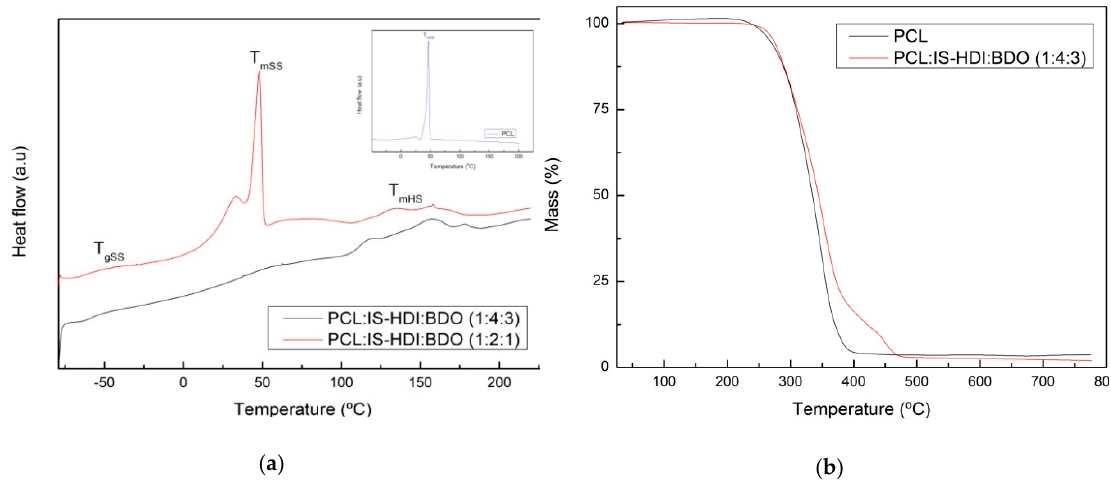
Figure 2. ( a ) DSC thermograms of PCL:IS-HDI:2,3-BDO and pure polyol ( b ) TGA curve PCL:IS- HDI:2,3-BDO (1:4:3) and pure